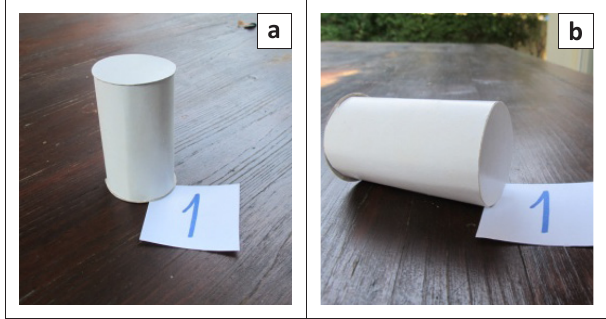
FIGURE 3: An example of a cylinder in a typical position (a) and an atypical position (b).